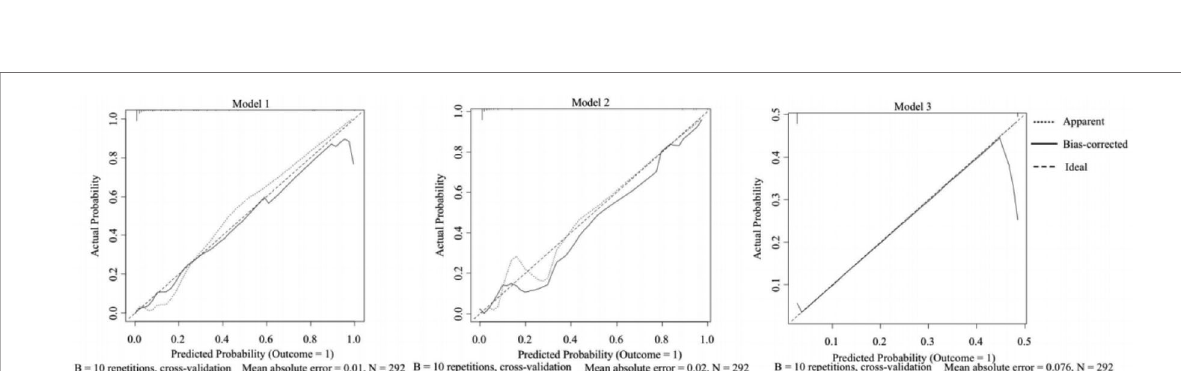
FIGURE 4 Prediction nomogram for neonatal phototherapy outcome created based on Model 1. The nomogram shows the weight of age, past medical history, presence of hemolysis, Hb, N%, ALB, and TSB in the training cohort. The line of each indicator is scaled with its range of values. The length of a line re fl ects the contribution of a factor to an outcome event. All scores are summed for a total point. The probability of prediction is resulted by drawing a perpendicular line at the total score.